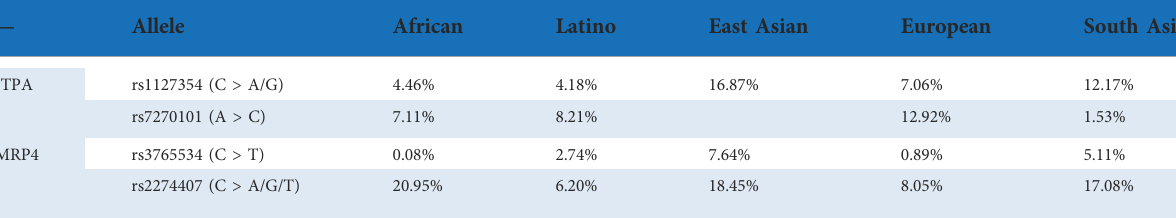
TABLE 2 Frequencies of the ITPA and MRP4 variants in major race/ethnic groups.